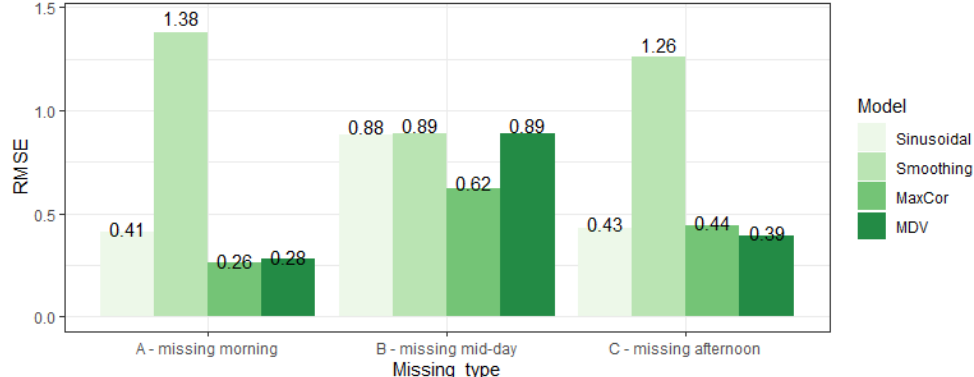
Figure 7. RMSE of daily ET a (in mm) for the infilled days with gaps, obtained from four infilling models for each evaluation dataset that represents typical patterns of missing data: A — missing morning; B — missing mid-day; and C — missing afternoon.